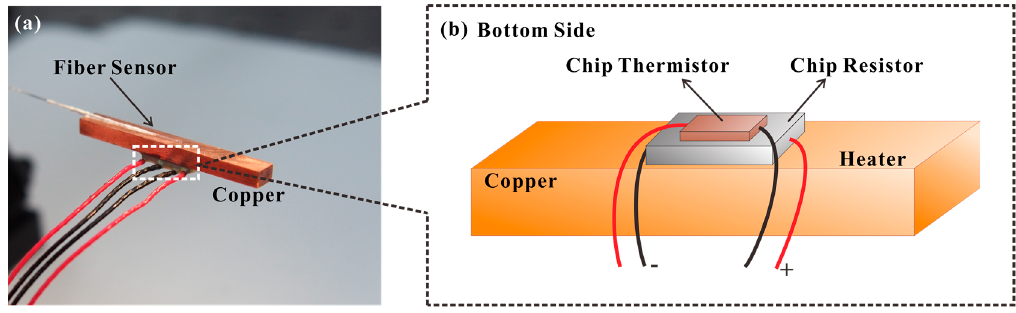
Figure 2. ( a ) Proposed low-cost chip resistor as a heating element; ( b ) bottom of the heating element.